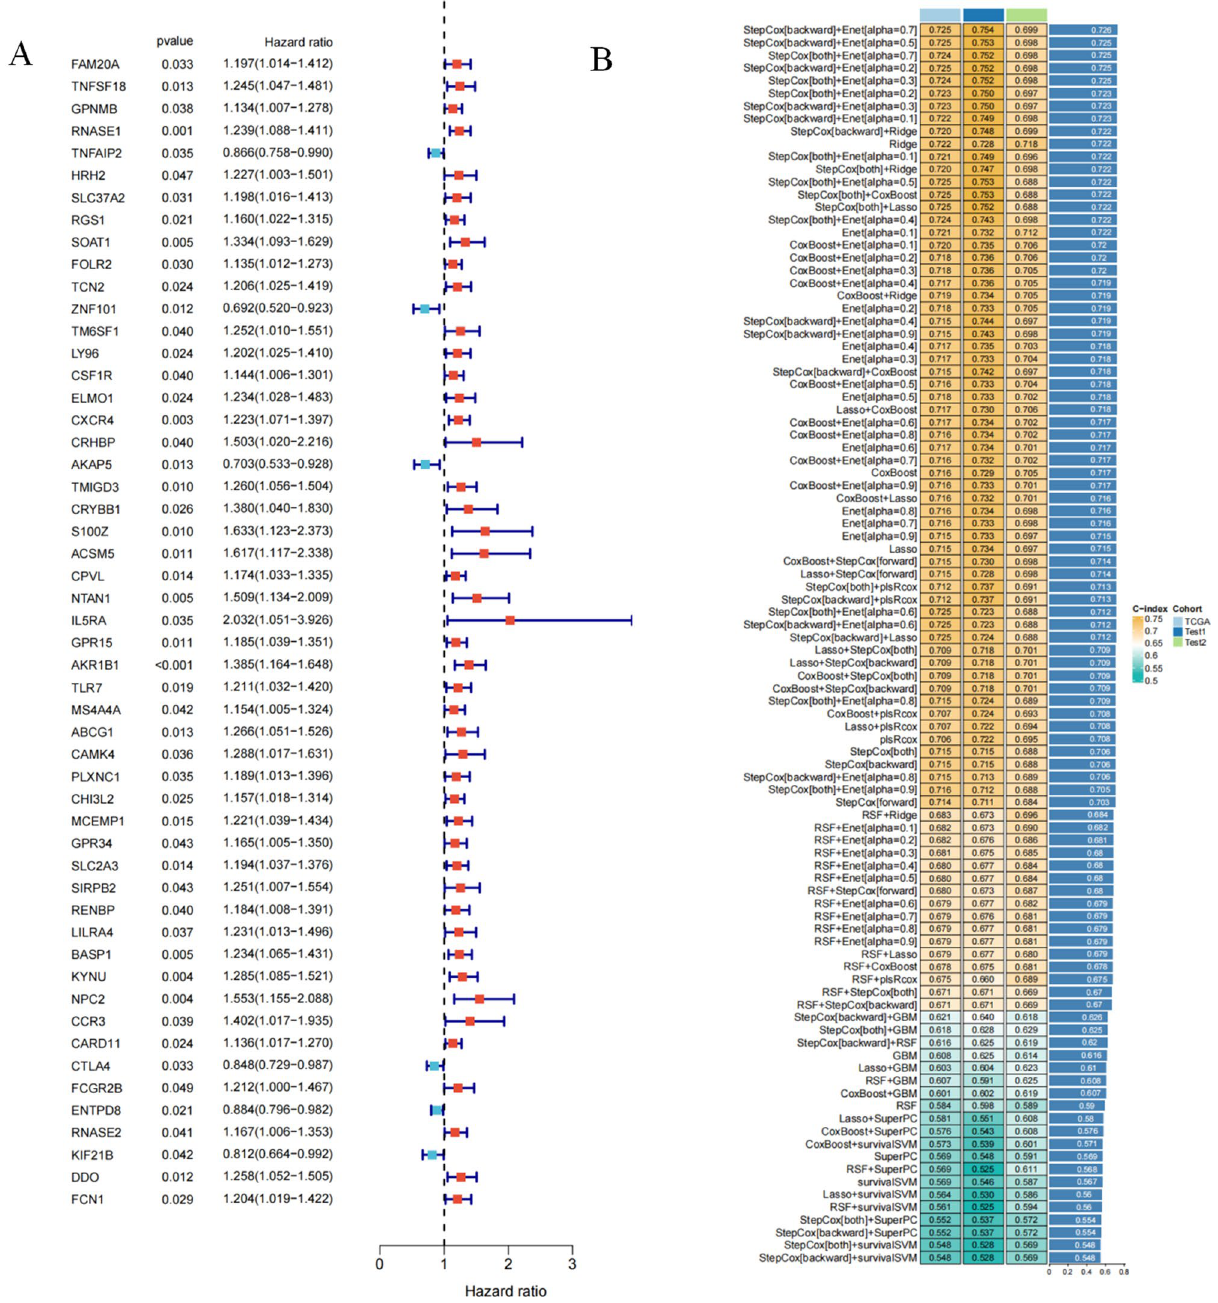
Determine StepCox[backward] + Enet[alpha = 0.7] as the best